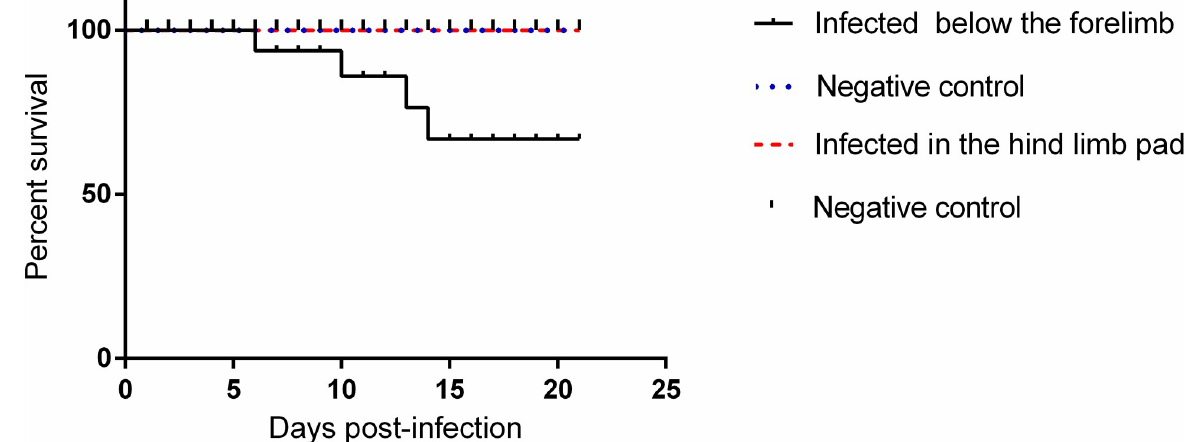
Fig 3. Survival of 15-day-old Balb/c mice infected below the forelimb subcutaneously. (N = 12 animals/group).